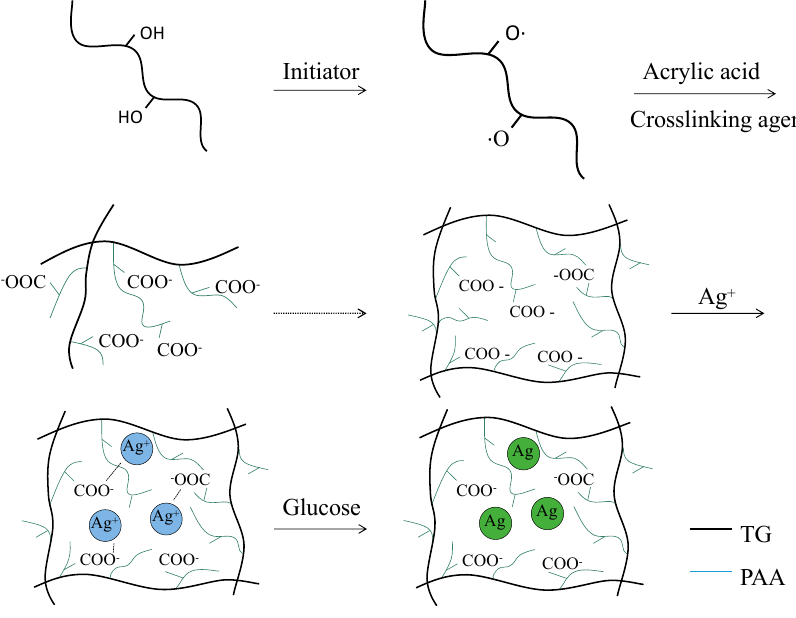
Figure 1. The schematic procedure of Ag particle formation in TG/Ag superabsorbent network.